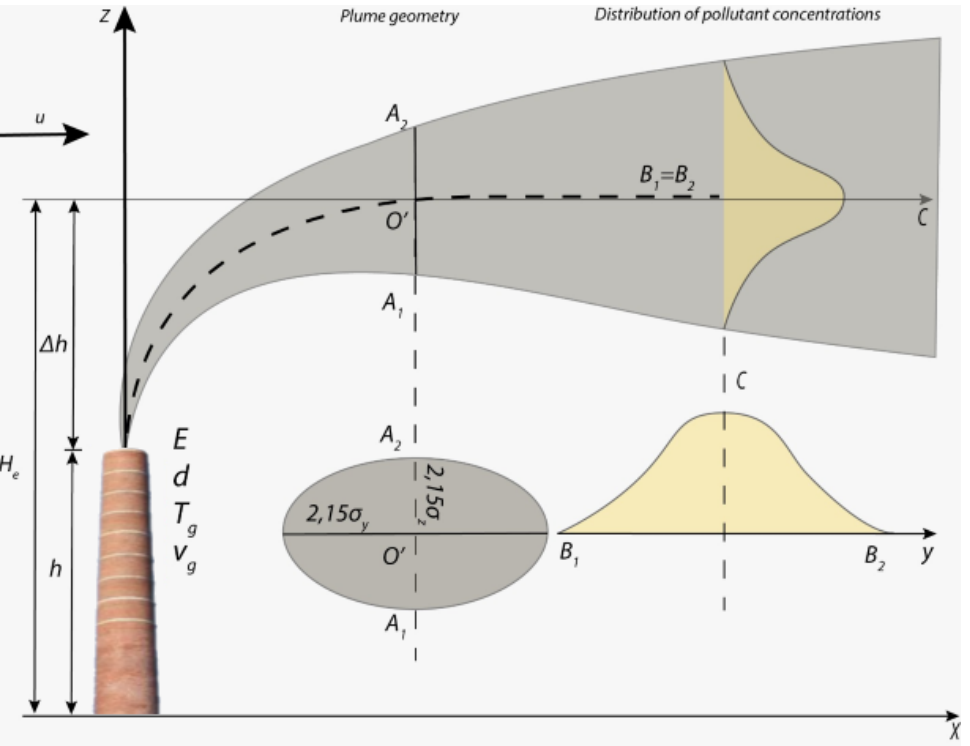
Figure 2. The parameters of the Gaussian plume model: E —intensity of pollutant emission from the source, d —internal diameter of the emitter outlet, T g , v g —temperature and speed of the gases at the outlet of the emitter, H e —effective height of emission, h —geometric height of the emitter, ∆ h —elevation of the gas plume, u —wind speed, σ y , σ z —standard deviations of the distribution of pollutant concentrations in the plume in horizontal and vertical directions, respectively